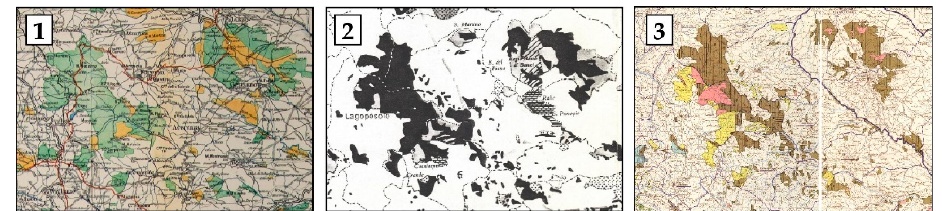
Figure 2. Extracts from historical cartographies of the same portion of the study area. Numbers refer to Table 1 in which the characteristics of maps are reported.